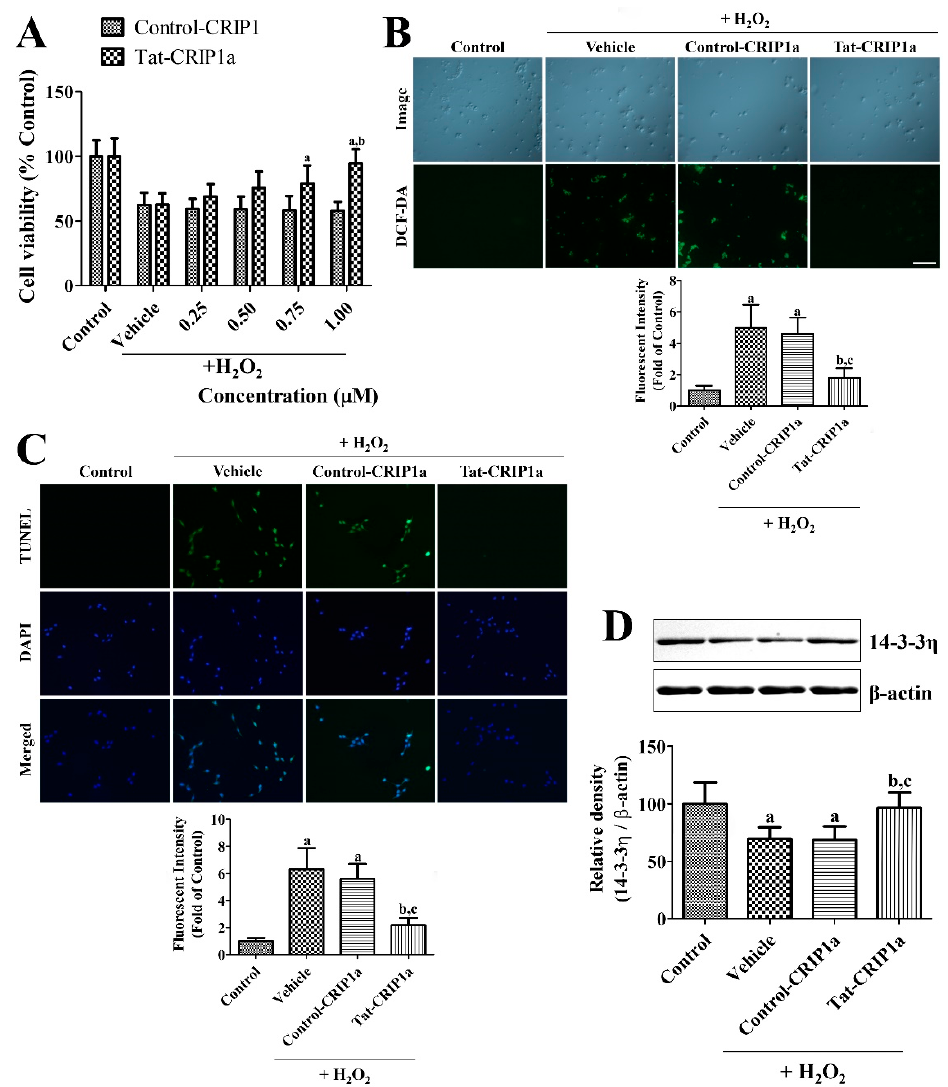
Figure 2. In vitro neuroprotective effects and mechanism of His-CRIP1a and Tat-His-CRIP1a proteins against H 2 O 2 -induced damage in HT22 cells. ( A ) Concentration-dependent cell viability was observed in HT22 cells after His-CRIP1a and Tat-His-CRIP1a treatment for 1 h and subsequent treatment with 1 mM H 2 O 2 for 5 h. A two-way ANOVA test was used to analyze the data followed by a Bonferroni’s post-hoc test ( a p < 0.05, significantly different from the Control-CRIP1a group; b p < 0.05, significantly different from the vehicle group). ( B ) H 2 O 2 -induced reactive oxygen species (ROS) production was measured with 1.0 μ M His-CRIP1a and Tat-His-CRIP1a treatment for 60 min and subsequent treatment with 1 mM H 2 O 2 for 10 min and 20 μ M 2 ′ ,7 ′ -dichlorofluorescein diacetate (DCF-DA) for 30 min. ( C ) H 2 O 2 -induced DNA fragmentation was visualized with TUNEL staining after 1 μ M His-CRIP1a and Tat-His-CRIP1a treatment for 1 h and subsequent treatment with 1 mM H 2 O 2 for 3 h. ( B and C ) Scale bar = 100 μ m. Intensities of DCF-stained and terminal deoxynucleotidyl transferase-mediated biotinylated dUTP nick end labeling (TUNEL)-positive cells were measured and the data are presented as percentile values vs. Control group. ( D ) Levels of 14-3-3 η were measured with Western blot after 1 μ M His-CRIP1a or Tat-His-CRIP1a proteins for 1 h and then treated with 1 mM H 2 O 2 for 3 h. The density of 14-3-3 η and β -actin bands were analyzed, and the data was calibrated with a ratio of 14-3-3 η / β -actin. A one-way ANOVA test was used to analyze the data followed by a Bonferroni’s post-hoc test ( a p < 0.05, significantly different from the control group; b p < 0.05, significantly different from the vehicle group; c p < 0.05, significantly different from the Control-CRIP1a group). Data are expressed as mean with standard deviation.